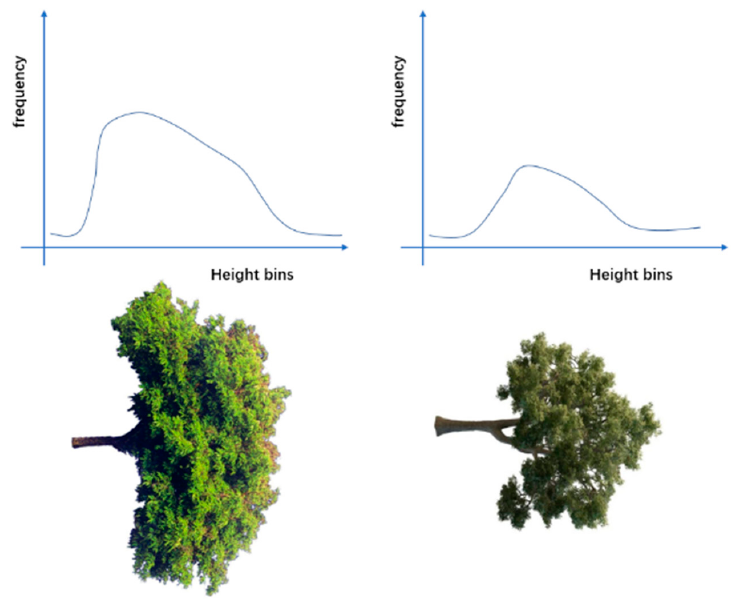
Figure 7. The profile curve in the vertical direction with different characteristics of a tree’s spatial structure.